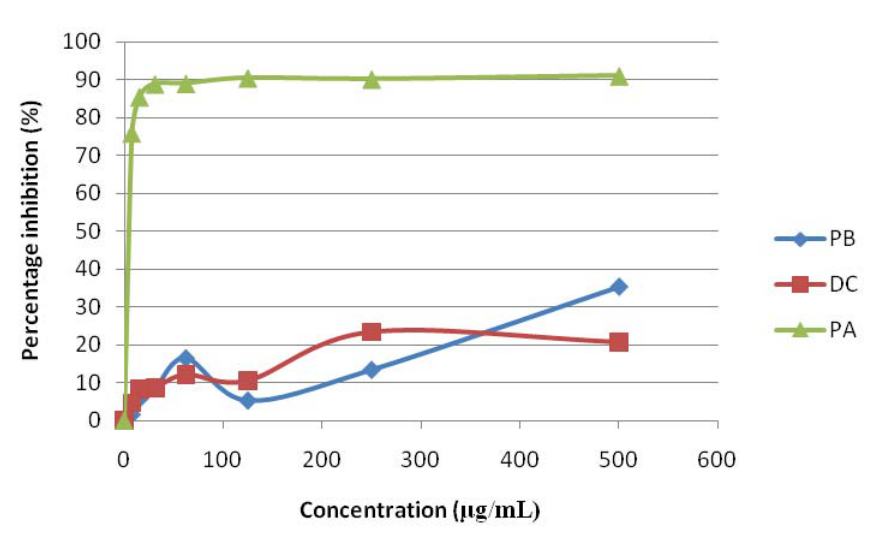
Figure 2. Percentage inhibition of DPPH (free radical) treated with different concentration of pyranocycloartobiloxanthone A ( 1 ) (PA), dihydroartoindonesianin C ( 2 ) (DC) and